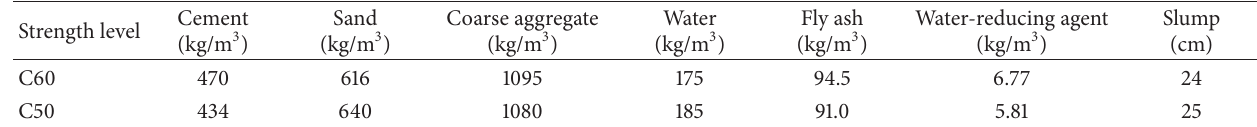
Table 1: Mix proportions and major parameters of